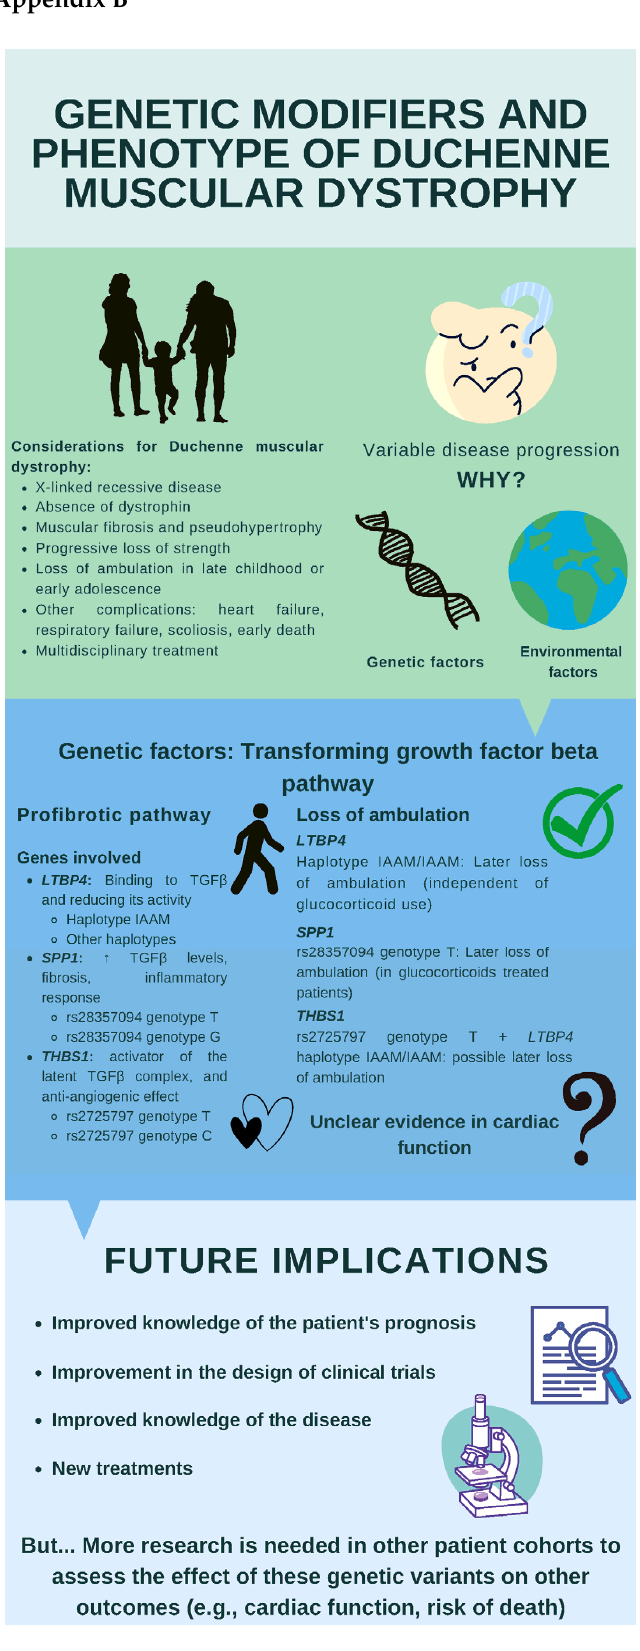
Figure A1. Infographic summary of the manuscript.